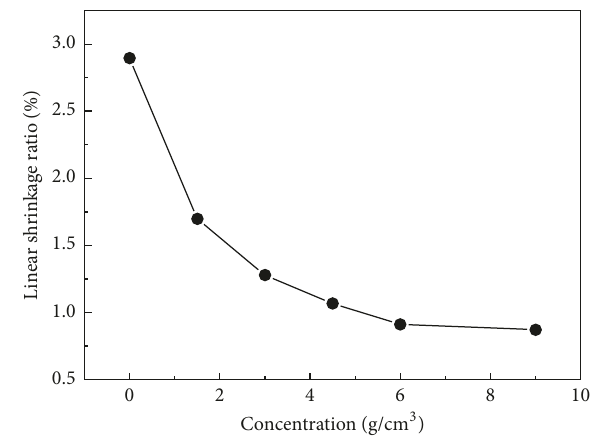
Figure 9: Effect of aqueous polymer concentration on linear shrinkage ratio of soils.